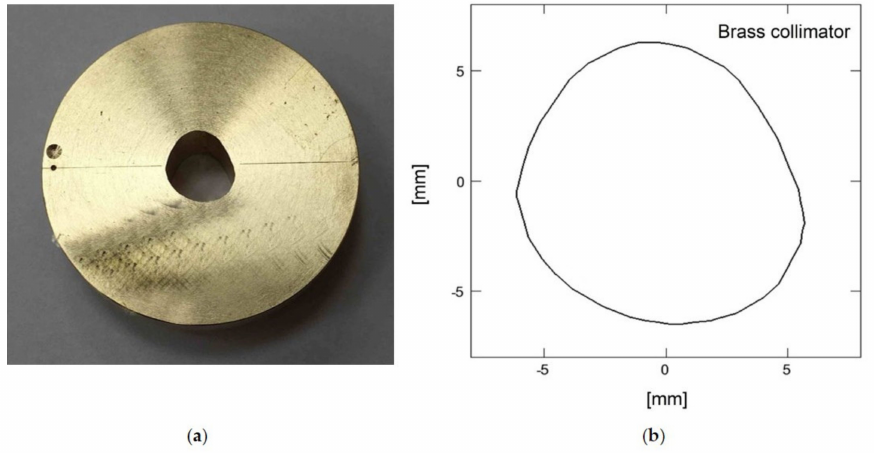
Figure 4. ( a ) Picture of the brass collimator used for proton irradiations; ( b ) The contour of the brass collimator with